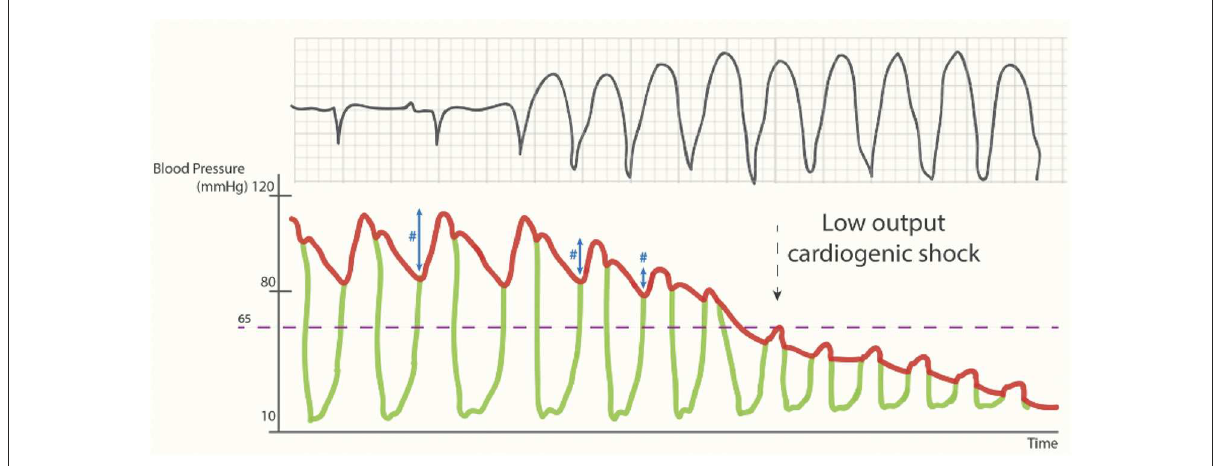
FIGURE2 Cardiac output during (unsupported) sustained ventricular tachycardia. Loss of pulse pressure (#) and cardiac output during the arrhythmogenic storm phase [reproduced with permission from